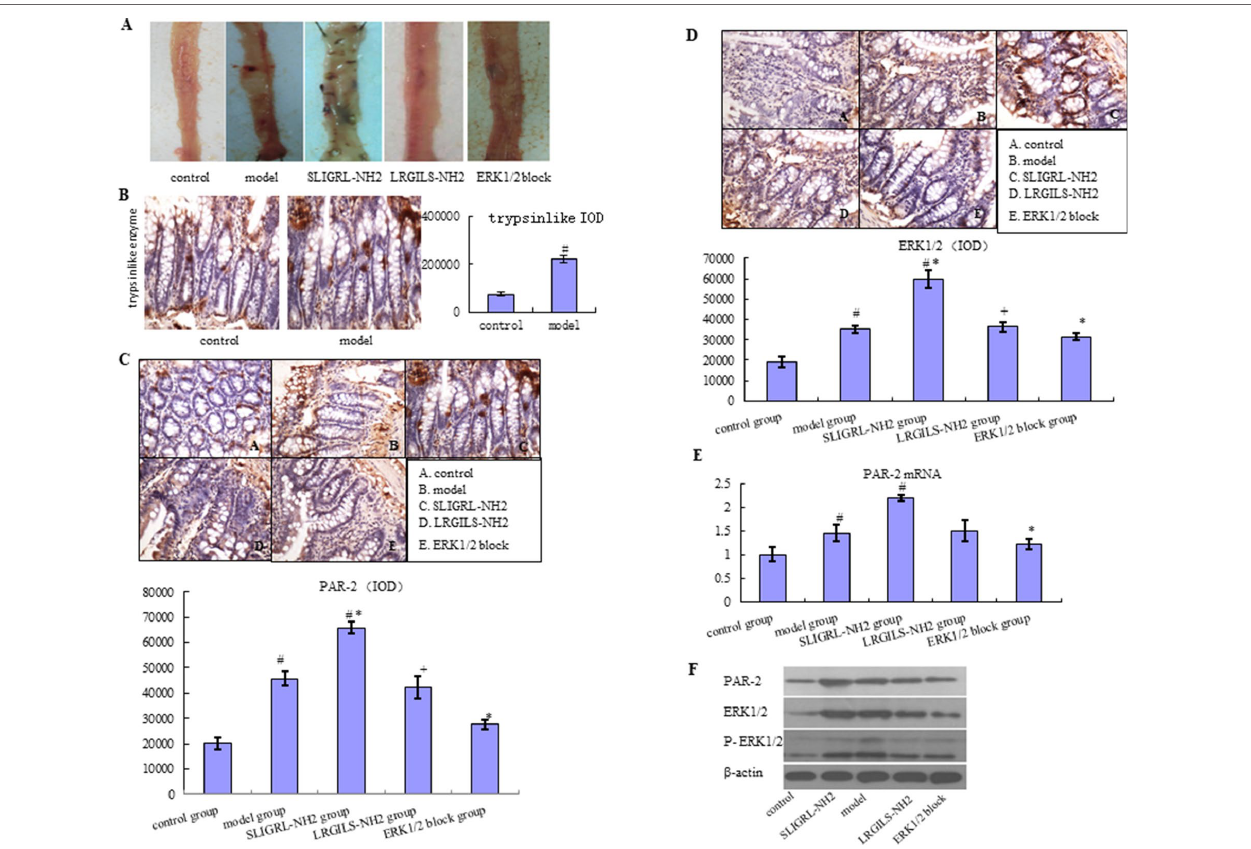
FIGURE 1 | Relationship between the PAR-2 and p-ERK1/2 expression with NSAID-induced small intestinal injury. (A) Macroscopic observation of small intestinal injury in control group, model group (diclofenac, 7.5 mg/kg BID, 5 days), SLIGRL-NH2 group (PAR-2 agonist group), LRGILS-NH2 group (PAR-2 antagonist group), and ERK blocker group. (B) The protein expression of tryptase was measured in control and model group by IHC (×400). The protein expression of PAR-2 (C) and p-ERK1/2 (D) was measured in control, model, SLIGRL-NH2, LRGILS-NH2, and ERK blocker group by IHC (×400). (E) The mRNA levels of PAR-2 were detected in control, model, SLIGRL-NH2, LRGILS-NH2, and ERK blocker group by qRT-PCR. (F) The protein expression of PAR-2 and p-ERK1/2 in control, model, SLIGRL-NH2, LRGILS-NH2, and ERK blocker group was measured by western blot. The bar graphs (mean ± SD) and representative images are shown. # p < 0.05 vs the control group, * p < 0.05 vs the model group. Representative views from each group are